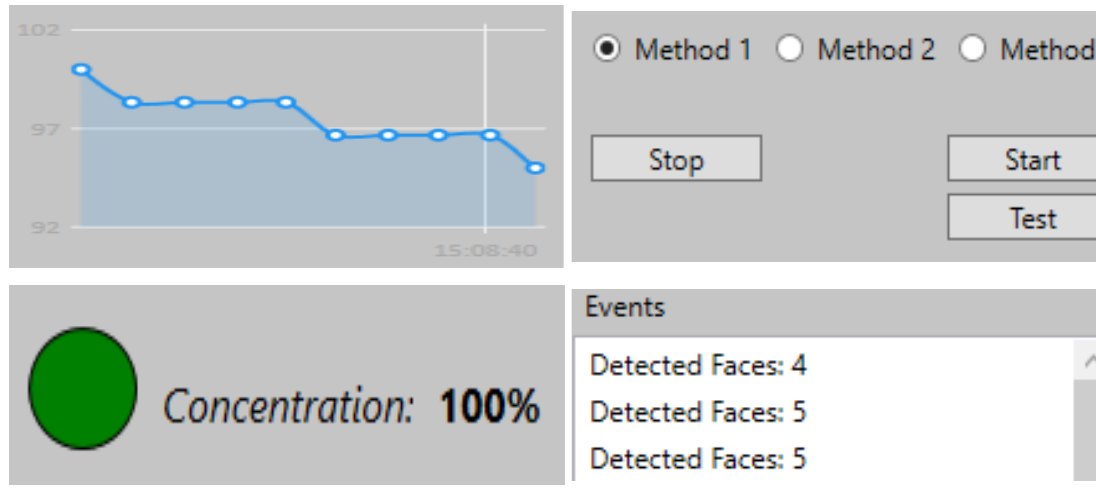
Figure 5. UI Features into Live Consultant Window.